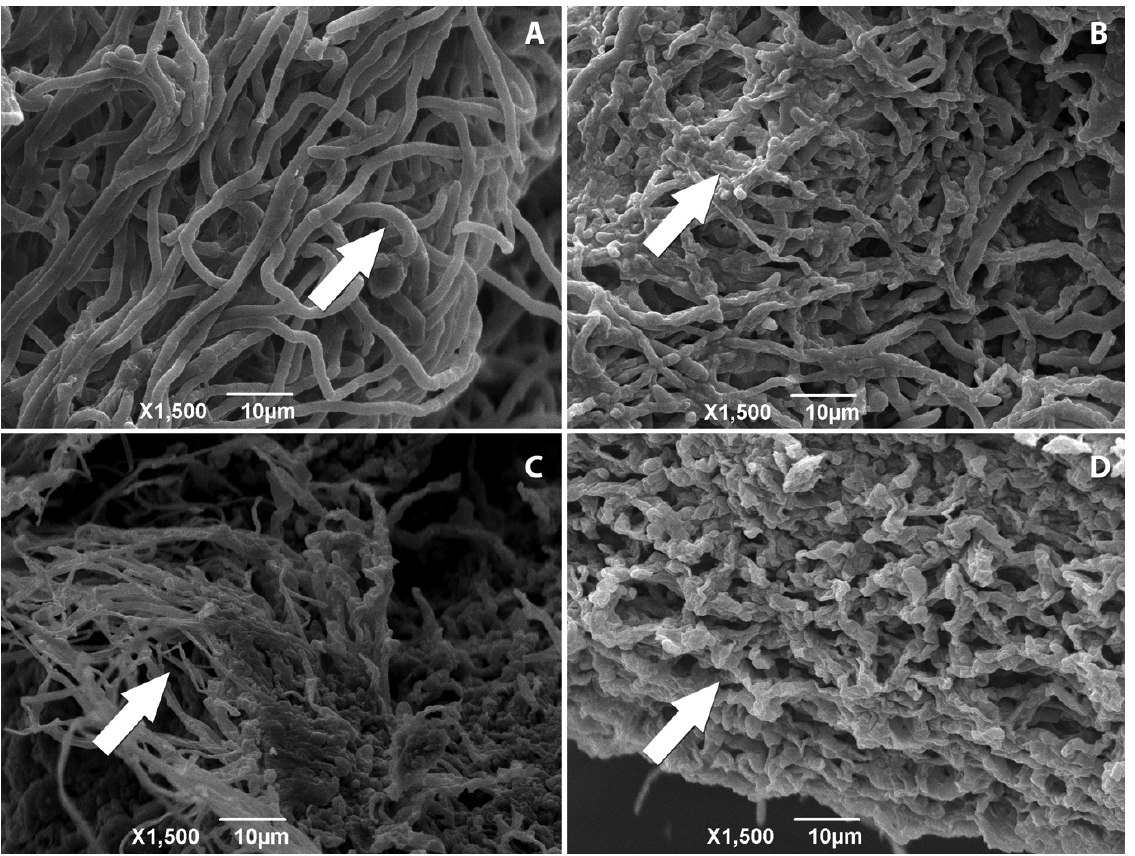
Figure 2. Electron micrographs of T. rubrum CCT 5507: ( A ) untreated — arrow indicates hyphae with morphological changes; ( B ) treated with copaiba oleoresin — arrow indicates the compression and clusters of hyphae without the original tubular shape; and ( C ) treated with ketoconazole and ( D ) treated with terbinafine — both arrows indicate the appearance of dried and wrinkled